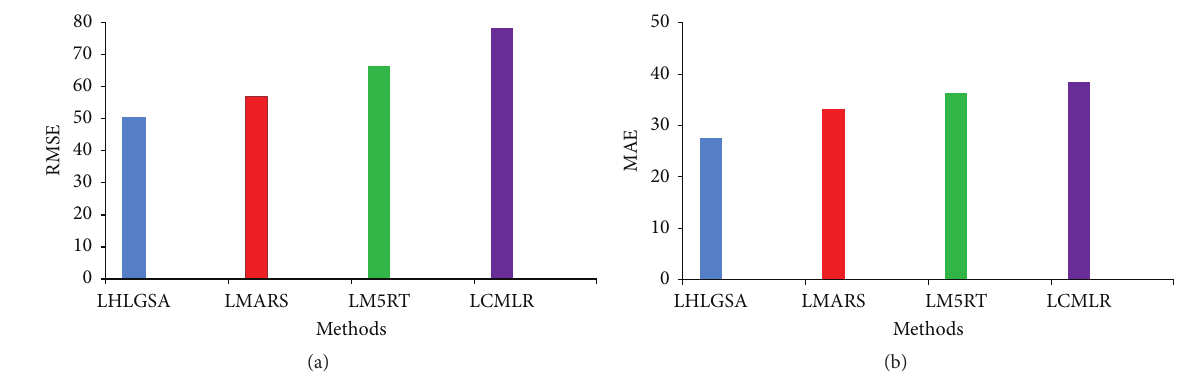
Figure 9: Overall errors of forecasted river flow using all log models for Astore